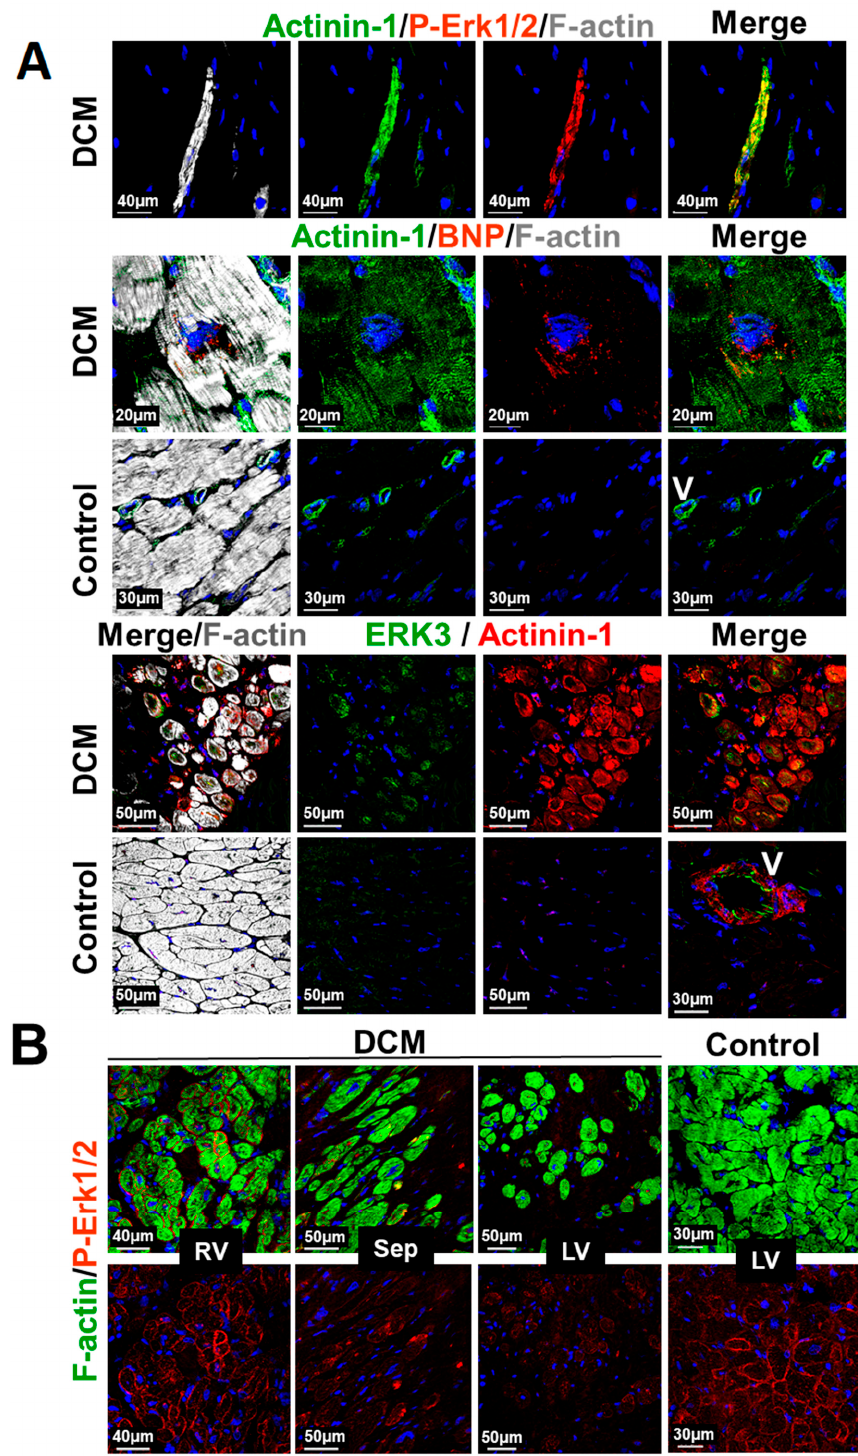
Figure 6. Structural and MAPK remodeling of cardiomyocytes in the myocardium of patients with dilated cardiomyopathy. ( A ) Confocal images of a transplanted patient with end-stage dilated cardiomyopathy (DCM). Upper images show an α -actinin-1 (Actinin-1)- and P-Erk-1 / 2-positive cell isolated from other cardiomyocytes in a fibrotic area of the myocardium. P-ERK1 / 2 indicates that the MAPK is still intact. Middle images depict α -actinin-1 positive cardiomyocyte expressing BNP. Lower images show cardiomyocytes reexpressing α -actinin-1 as well as Erk3. Controls show neither ERK3 nor actinin-1 expression. V indicates a vessel and serves as positive control for actinin-1. ( B ) Confocal fluorescence images of a transplanted 12-year-old patient with left ventricular assist device. Note the P-ERK1 / 2-decreasing gradient from the right ventricle (RV) over the septum (Sep) to the left ventricle (LV). LV control serves an age-matched patient with Tetralogy of